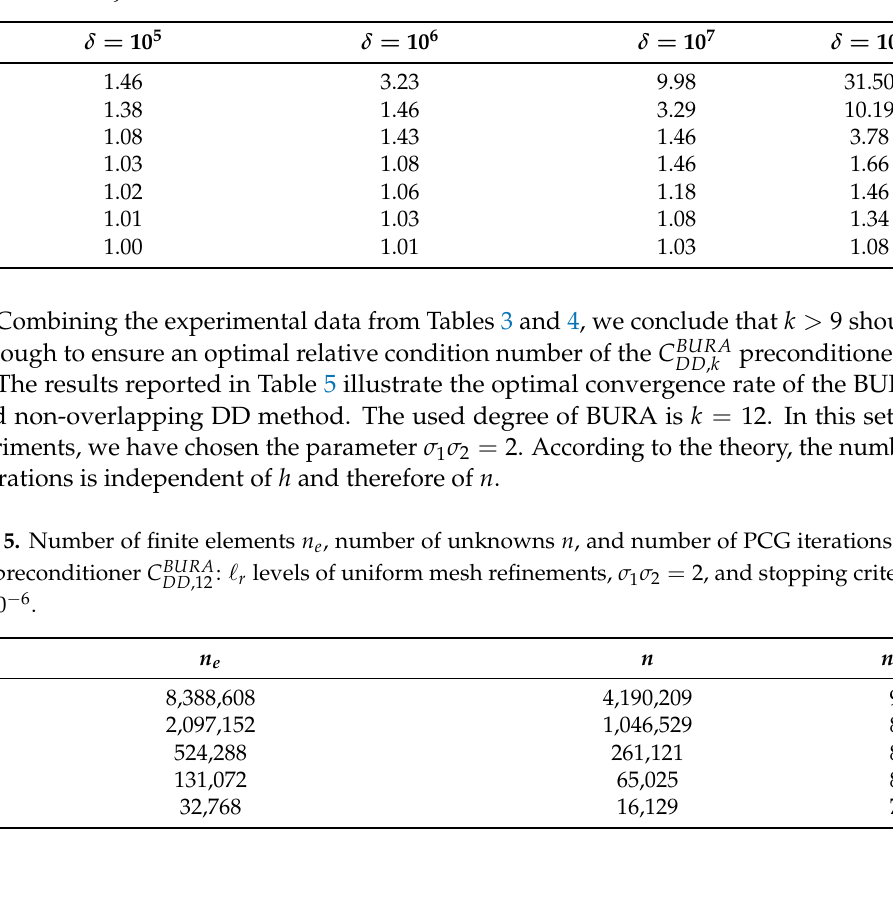
(cid:16) (cid:17) [ C BURA ( L γ )] − 1 L 0.5 , with respect to 3 ≤ k ≤ 9, for δ = κ ( L γ ) ∈ γ 0.5, k